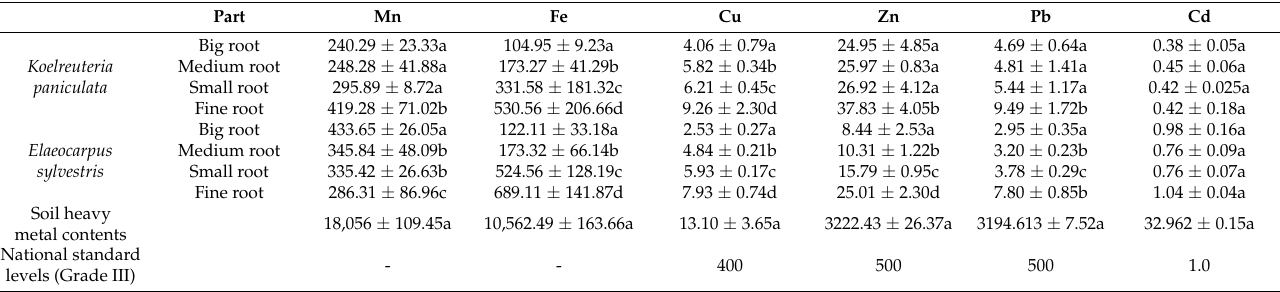
Table 3. The heavy metal content in root of plantation